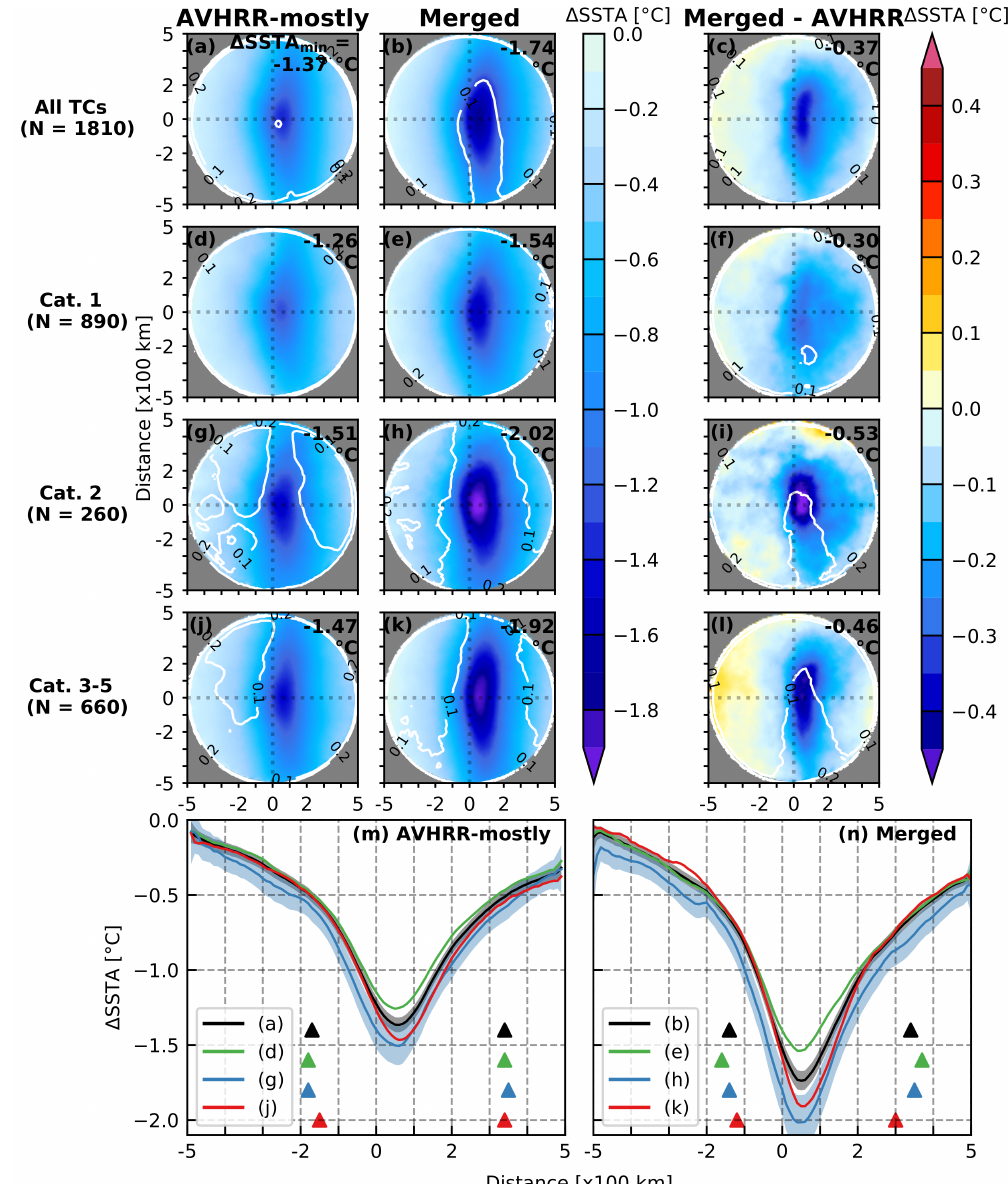
Figure 5. First column: Composite of ∆ SSTA induced by hurricanes using AVHRR-mostly data for: ( a ) all hurricanes, ( d ) hurricanes of category 1, ( g ) category 2, ( j ) categories 3–5; Second column: same but for merged data for: ( b ) all hurricanes, ( e ) hurricanes of category 1, ( h ) category 2, ( k ) categories 3–5; Third column: difference between first and second columns ( merged − AVHRR-mostly ) for: ( c ) all hurricanes, ( f ) hurricanes of category 1, ( i ) category 2, ( l ) categories 3–5; ( m , n ) cross-section at the center ( y = 0) and in the perpendicular direction to the hurricane movement ( x -axis) of the composites of ∆ SSTA for AVHRR-mostly and merged datasets respectively. N is the number of observations. Uncertainties of ∆ SSTA (margin of error) are indicated by white contours in ( a – l ) panels and with shading in ( m , n ). The minimum ∆ SSTA ( ∆ SSTA min ) is written at the top-right corner in each panel. Edges of cold wakes are indicated with triangles in ( m , n ) with same colors than curves (see legend). Note the different range of colors used for the third column (magnitude of differences shown by the symmetric colorbar). Detailed numbers are shown in Table